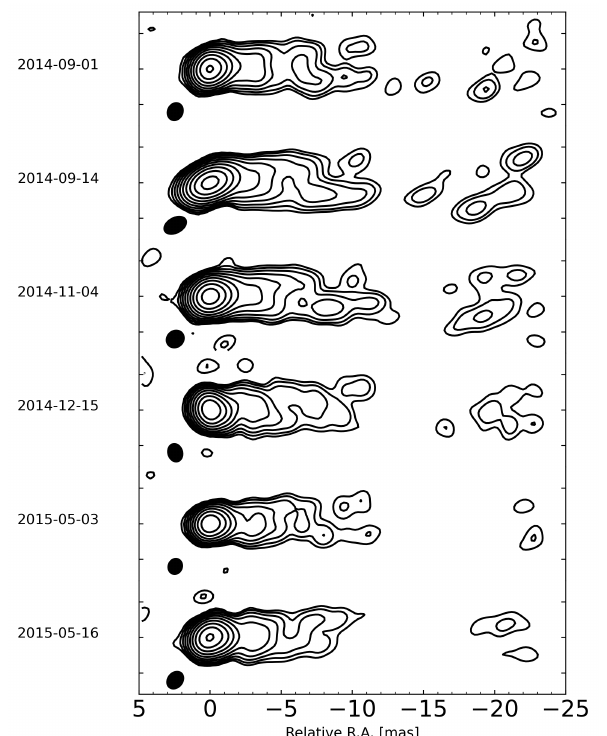
Figure A1. Total intensity maps of KaVA 22GHz observations of the M87 jet between September 01 2014 and May 16 2015. Contours start at 3 σ rms , increasing in steps of 2. The synthesized beam for individual epochs is drawn as a black ellipse on the bottom left side of the individual